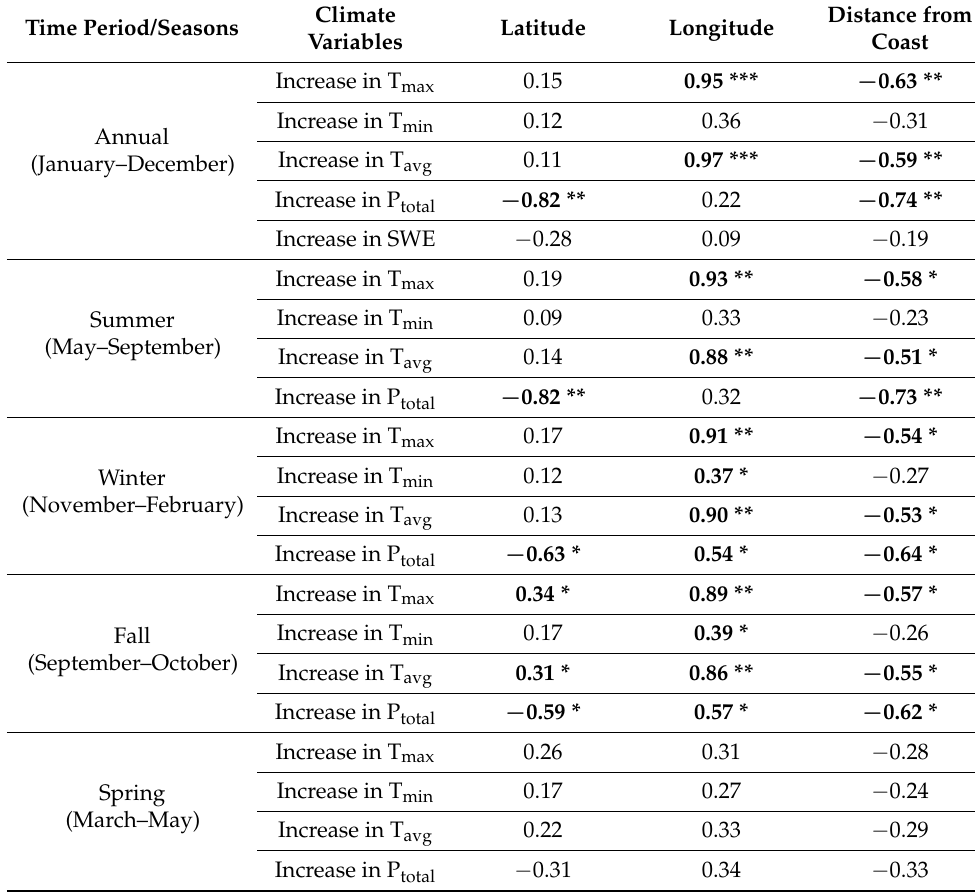
Table 2. Correlation analysis of the increases in climate variables (increase in Tmax, Tmin, Tavg, Ptotal, and SWE) with the geographic factors (latitude, longitude, and distance from the coast) for the studied wild blueberry barrens of Maine (shown in Figure 1) during different seasons at the significance level of p < 0.05 *, p < 0.01 **, and p < 0.001